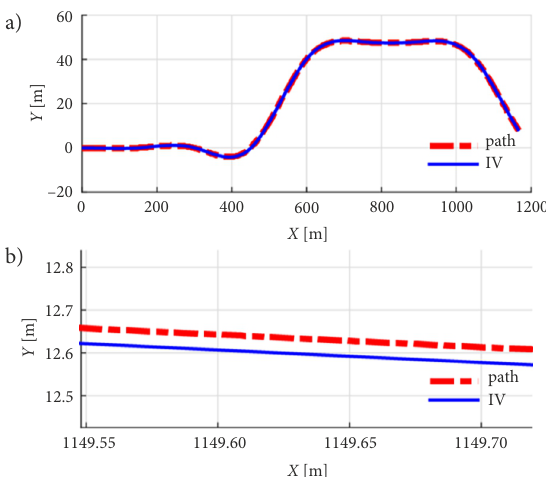
Figure 16. Path tracking of the intelligent vehicle (source: created by the authors): a – global view; b – local view; IV – intelligent